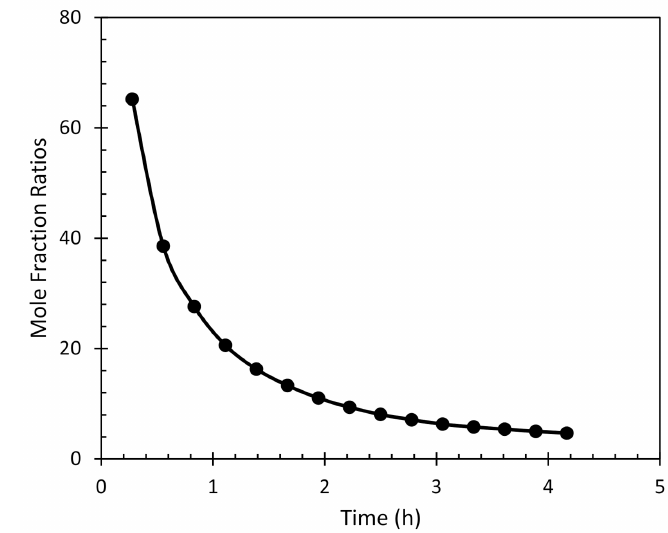
Figure 13. Mole fraction ratios as a function of